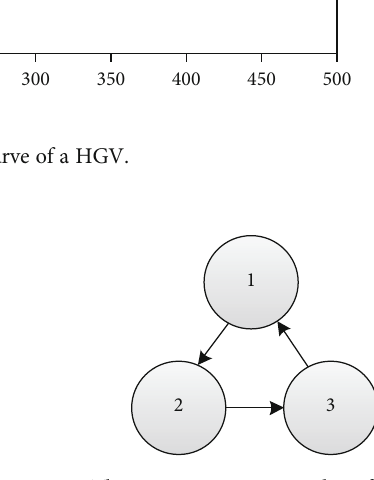
Figure 4: The communication topology for three